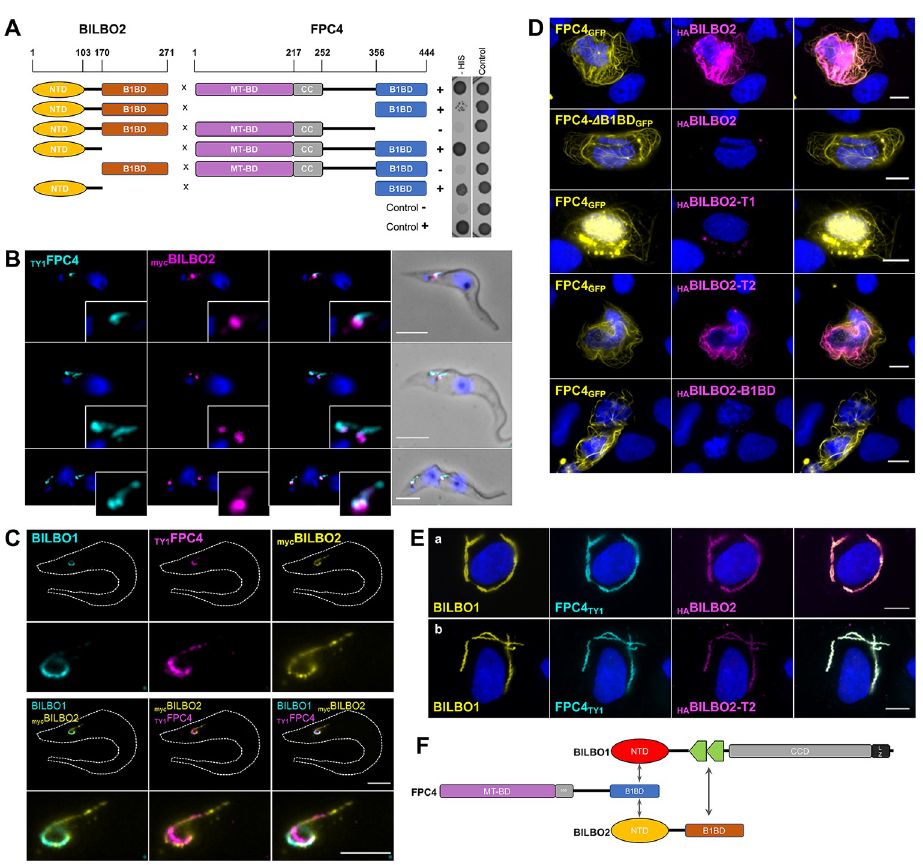
Fig 6. Interaction between BILBO2 and FPC4 is similar to that of BILBO1 and FPC4. A. Y2H interaction assay between BILBO2 and FPC4 and domains. B. Immuno-colocalisation of TY1 FPC4 and BILBO2 in detergent-extracted PCF cells. Scale bars 5 μ m. C. Immunolocalization of BILBO1, myc BILBO2 and TY1 FPC4 using U-ExM in detergent- extracted PCF cells. Scale bars 10 μ m and 5 μ m in enlarged inset. D. Expression in U-2 OS cell and immunolocalization of FPC4 GFP and FPC4 deleted of its B1BD (FPC4- Δ B1BD GFP ) and HA BILBO2 and domains demonstrating that the BILBO2-T1 (aa 1–103) domain is not sufficient for a stable interaction between BILBO2 and FPC4 whereas a longer domain (BILBO2-T2) is stabilizing the interaction. Cells were detergent-extracted before the IF to reduce the FPC4 and BILBO2 cytosolic labelling. Scale bars 10 μ m. E. A tripartite interaction is demonstrated in U-2 OS cells by the co-labelling of FPC4 and BILBO2 and domains onto the BILBO1 polymers. Scale bars 10 μ m. F. Schematic representation of the interactions between BILBO1, BILBO2 and FPC4.